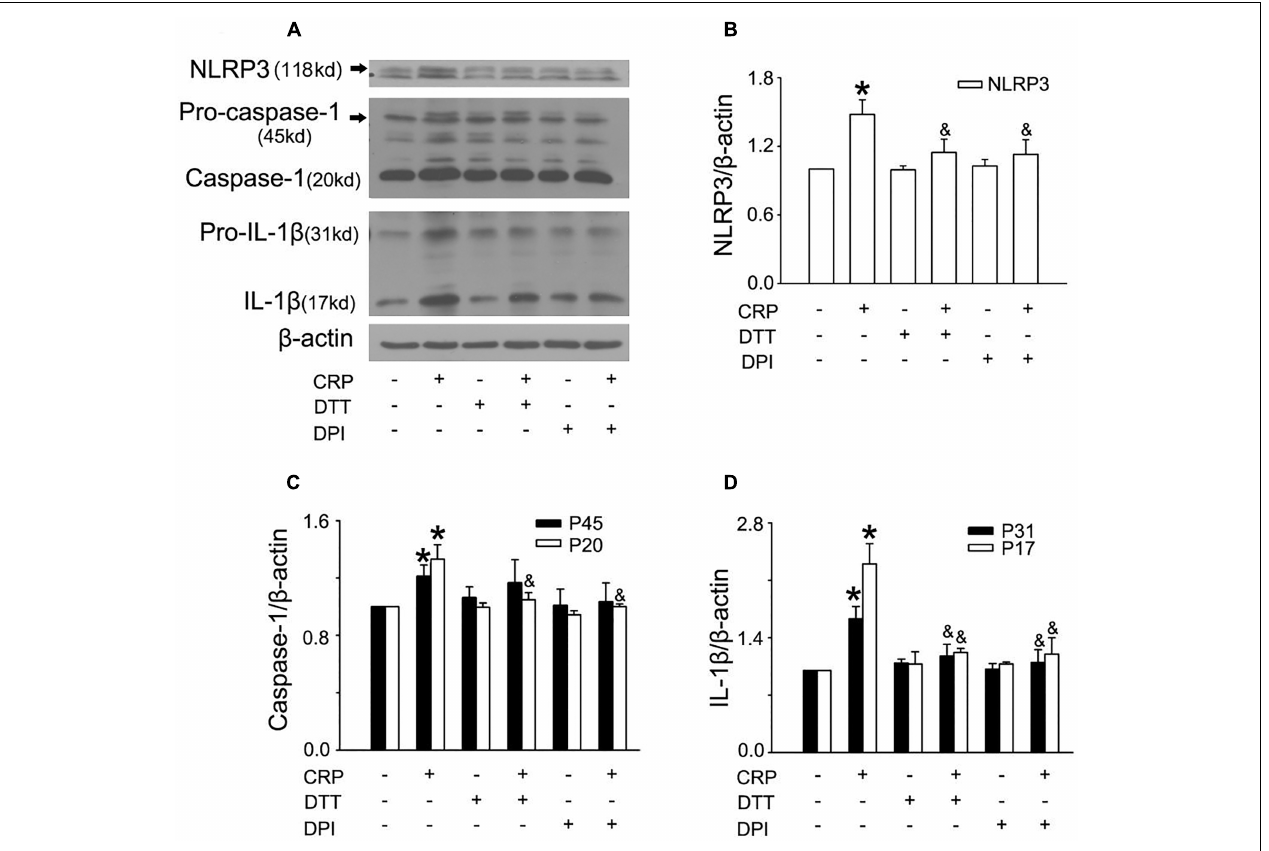
FIGURE 3 | Reactive oxygen species (ROS) are implicated in CRP-induced NLRP3 inflammasome activation. HUVECs were incubated with 10 µ mol/L DPI, or 30 µ mol/L DTT for 30 min, and then were treated in the absence or presence of 20 µ g/mL CRP for 24 h. (A) Representative Western blots showing the expression of NLRP3, pro-caspase-1, caspase-1, pro-IL-1 β , and IL-1 β . (B–D) Summary bar graphs showing the expression of proteins. ∗ P < 0.05 vs. Ctr; & P < 0.05 vs. CRP; n =